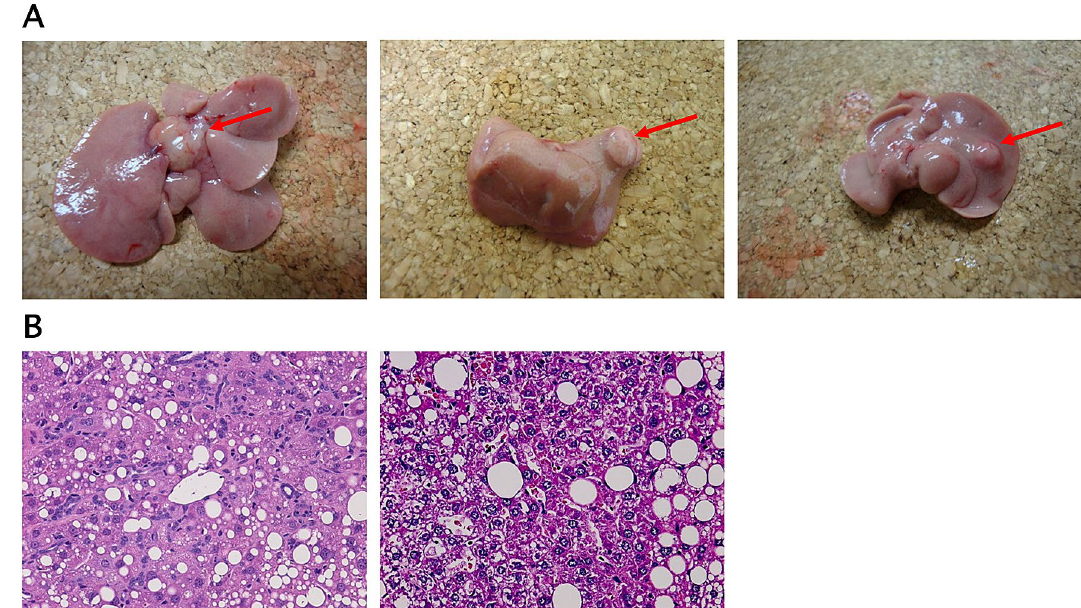
Figure 3. Mutyh −/− mice fed an HFHC + high iron diet developed liver tumors. ( A ) Arrows indicate liver tumors. Gross liver appearance of Mutyh −/− mice fed an HFHC + high iron diet, showing single tumor foci at the time of necropsy. ( B ) Liver tumor sections (H&E × 100). HFHC, high-fat high-carbohydrate; H&E, hematoxylin & eosin. Numbers of Feeding period Diet Mutyh Genotype